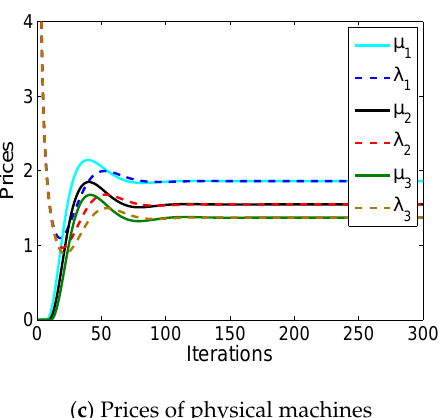
Figure 7. Performance of the resource allocation algorithm for application deployment in a simple